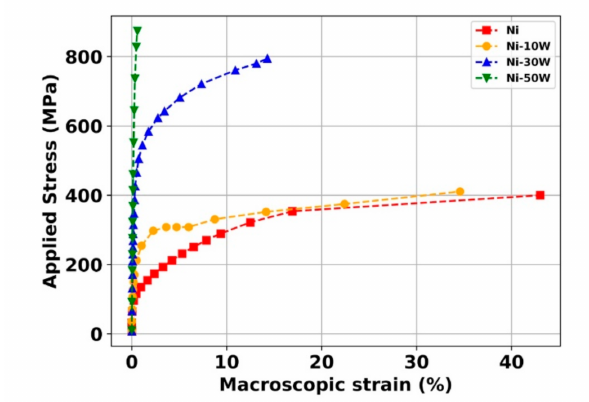
Figure 2. Applied stress as a function of the macroscopic strain of the bulk Ni and Ni-W